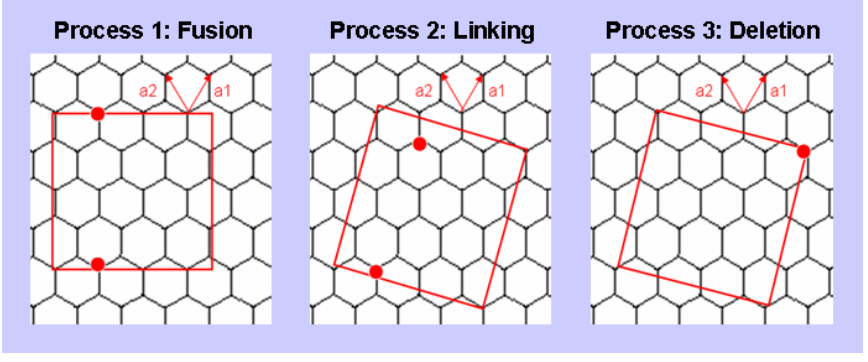
Figure 8. Finishing processes used for creating a